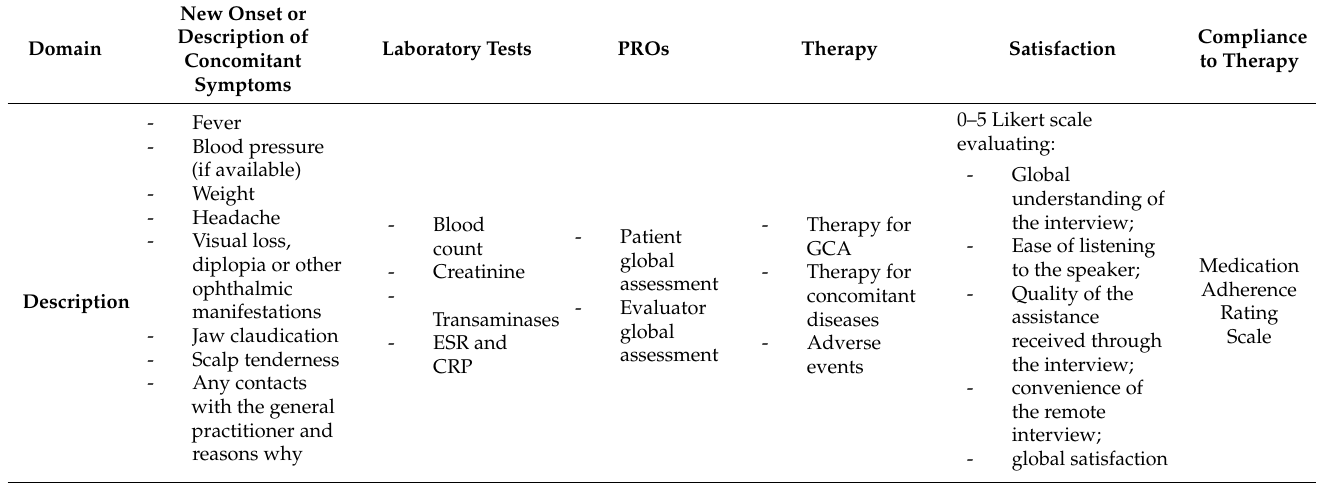
Table 1. Domains and related information recorded during the